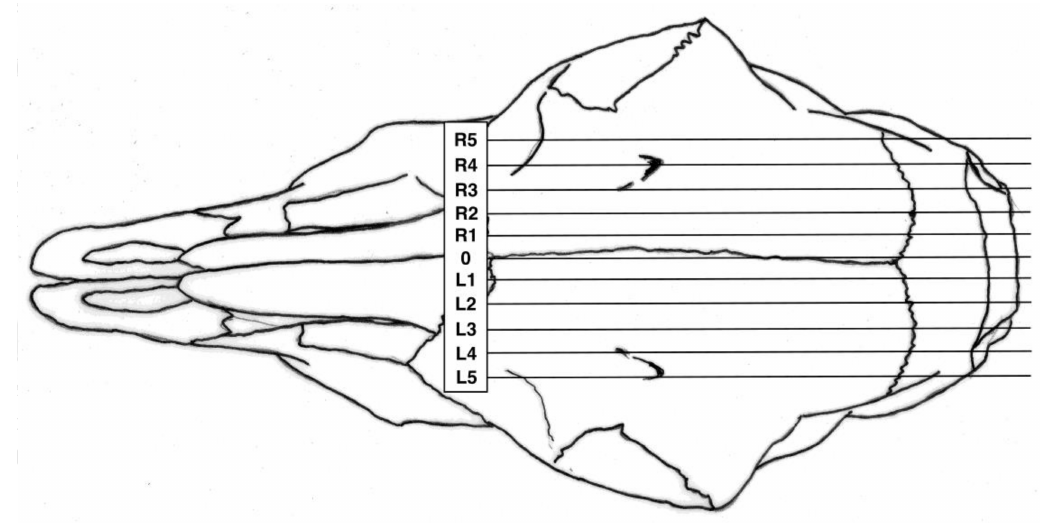
Figure 2. Lateral target area, with 0 representing the midline based on the suture of the paired frontal bones, L figures being to the left and R figures being to the right of this midline.